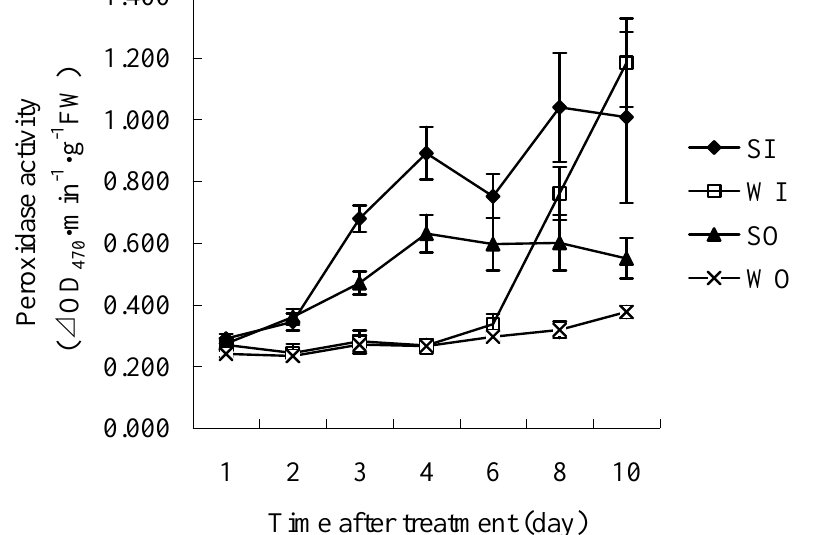
Figure 2. Peroxidase activity in pumpkin leaves upon osthol application and/or S. fuliginea inoculation. Non-osthol-treated and non-inoculated plants (WO), plants treated with osthol and non-inoculated (SO), non-osthol-treated plant inoculated (WI) and osthol- treated plant inoculated with S. fuliginea (SI). Each value is the mean ± S.E. for